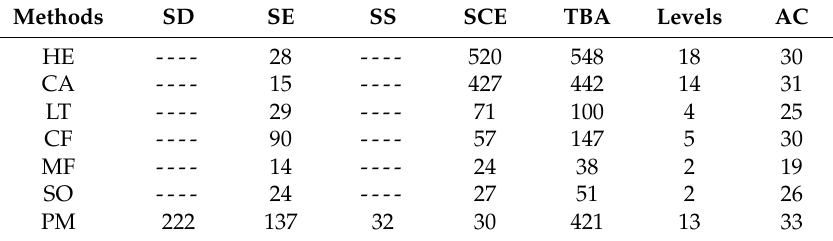
Table 3. Time statistics for stripe image processing